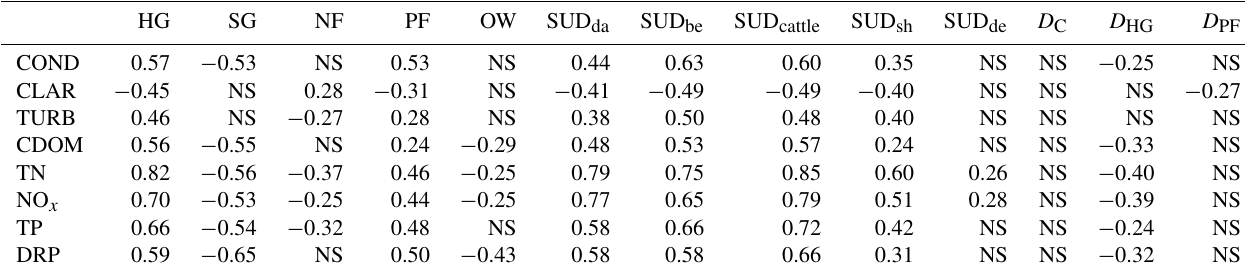
Table 7. Correlations of water quality (median values) vs. the major land uses, livestock densities, and median catchment disturbance of the 77 NRWQN catchments. All values represent Spearman correlation coefficients ( r s ) . Non-significant relationships ( p ≥ 0 . 05) are denoted by NS. T w was not included because of its strong latitudinal trend. DO and pH w were not included because they had no significant relationships with land use. SUD cattle is the combination of dairy and beef cattle.